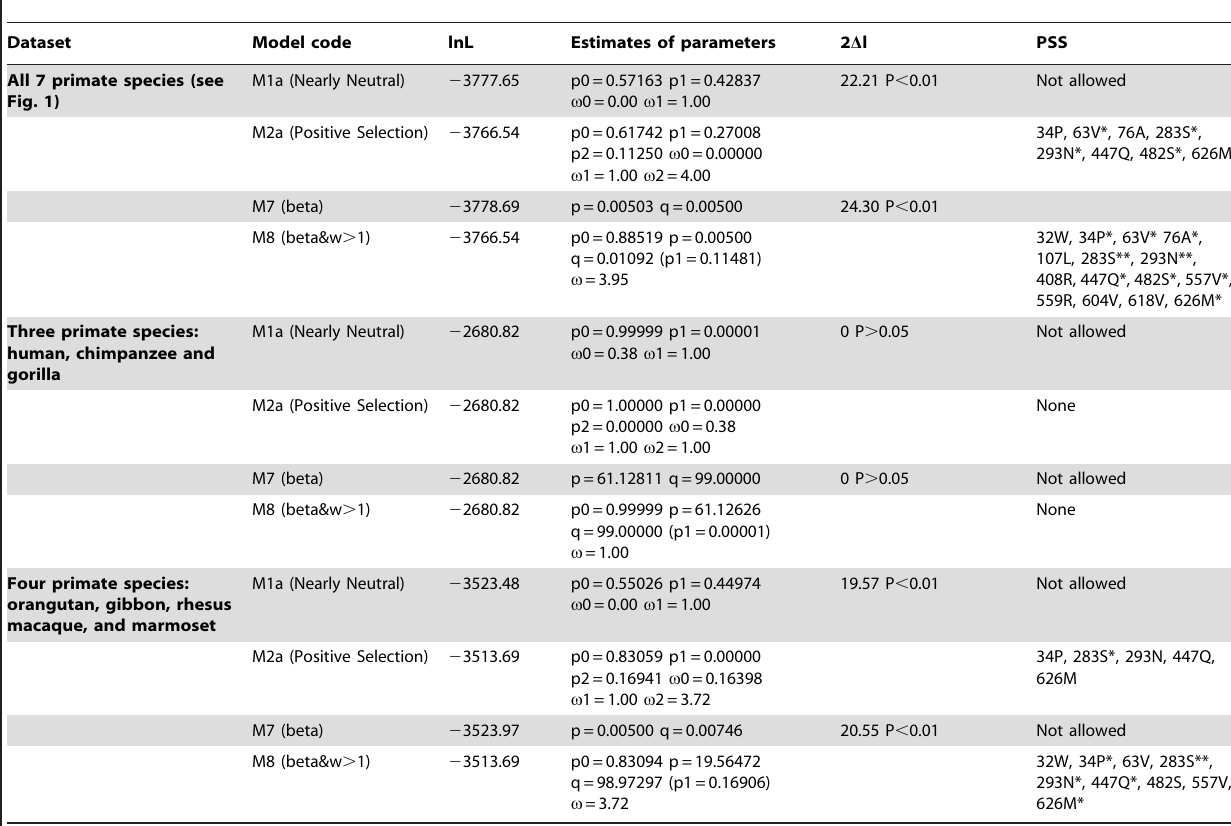
Table 1. Phylogenetic analysis by maximum likelihood estimation of the primate SAMHD1 genes.